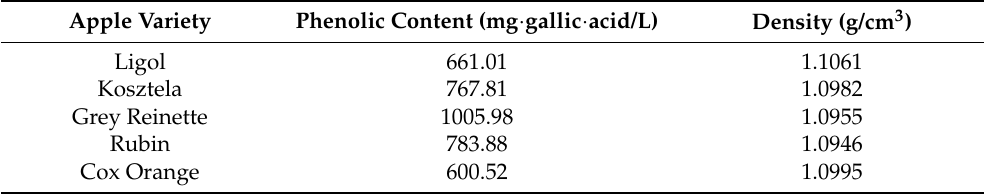
Table 1. Phenolic content and density of liqueurs made from different varieties of